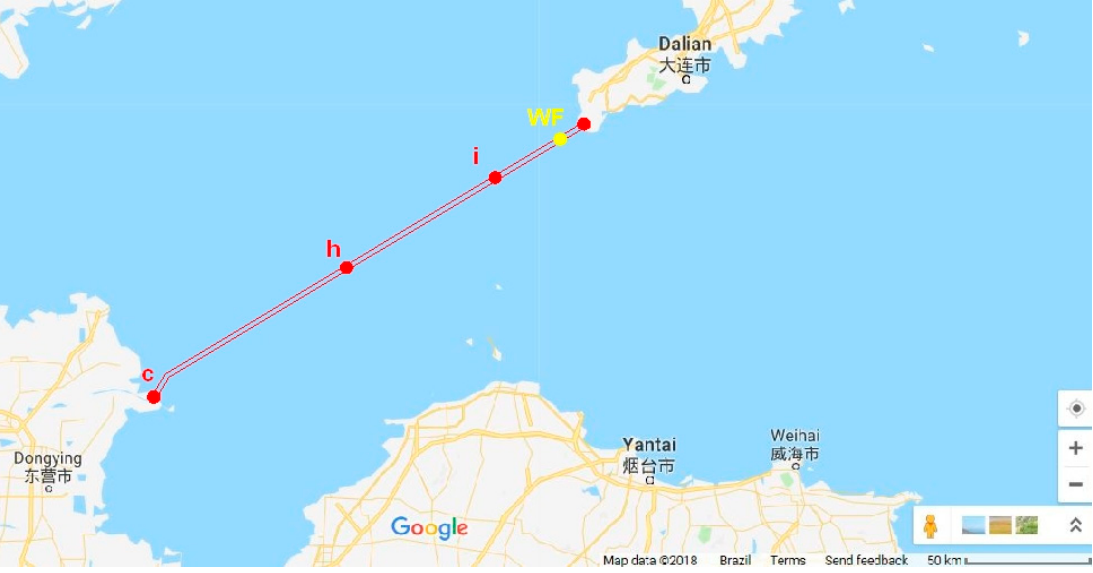
Figure 4. Location of the pipeline Huanghe/Dalian, China; letters in bold mean pumping units. WF is the location of the wind power plant. Map source: [49].